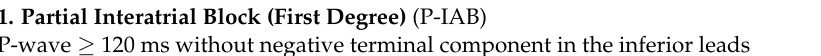
Table 1. ECG classification of interatrial blocks